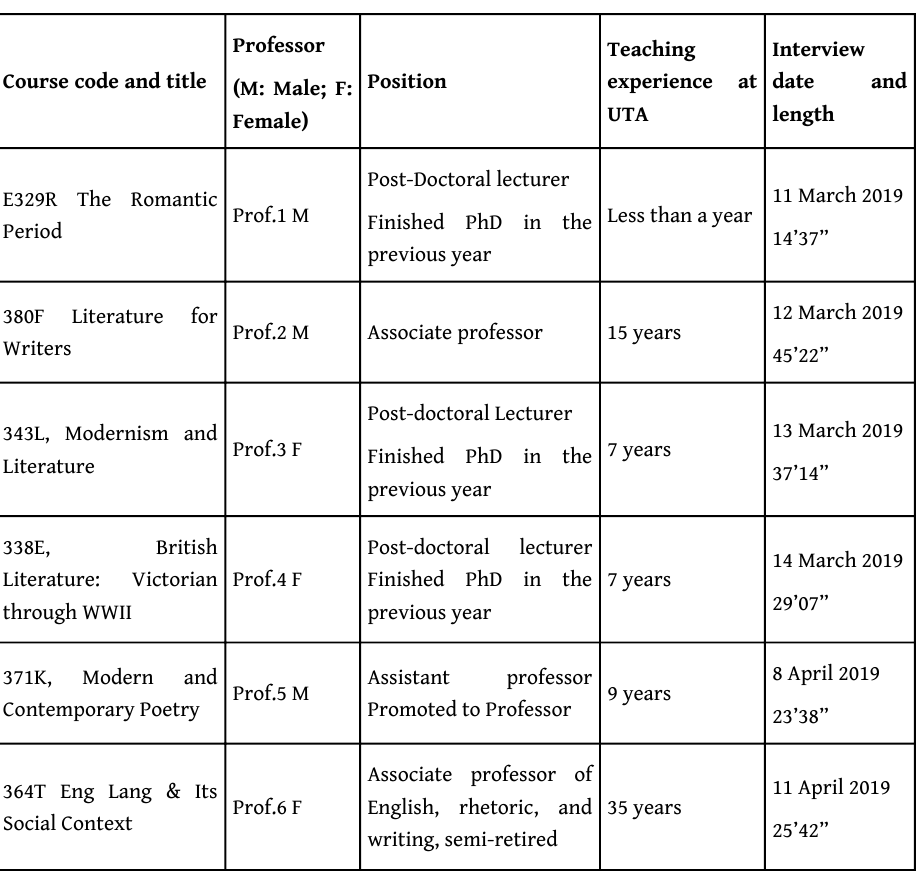
Table 1: The profiles of the six professors interviewed